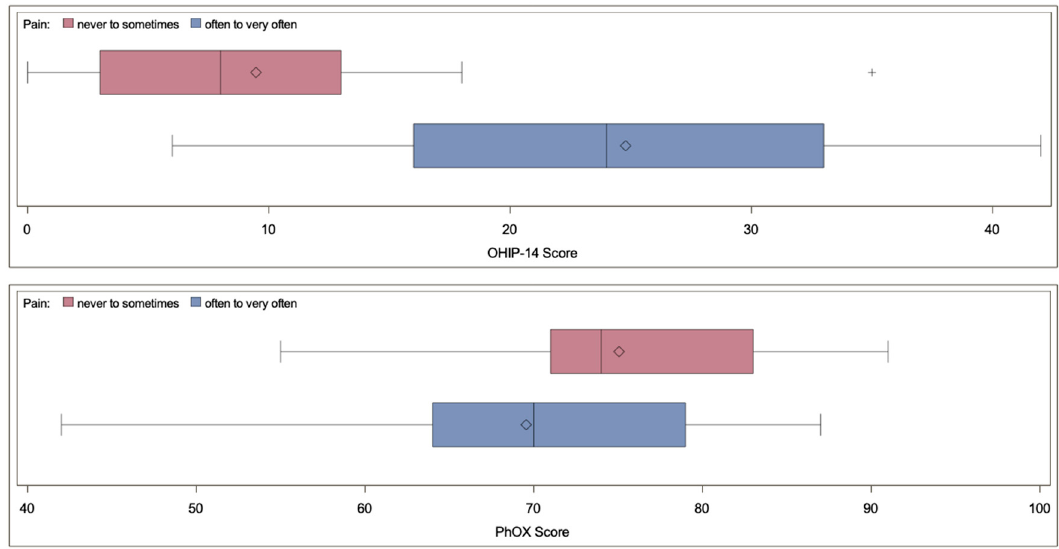
Figure 3. Boxplots for OHIP-14 score and PhOX score categorized into two groups. The red group